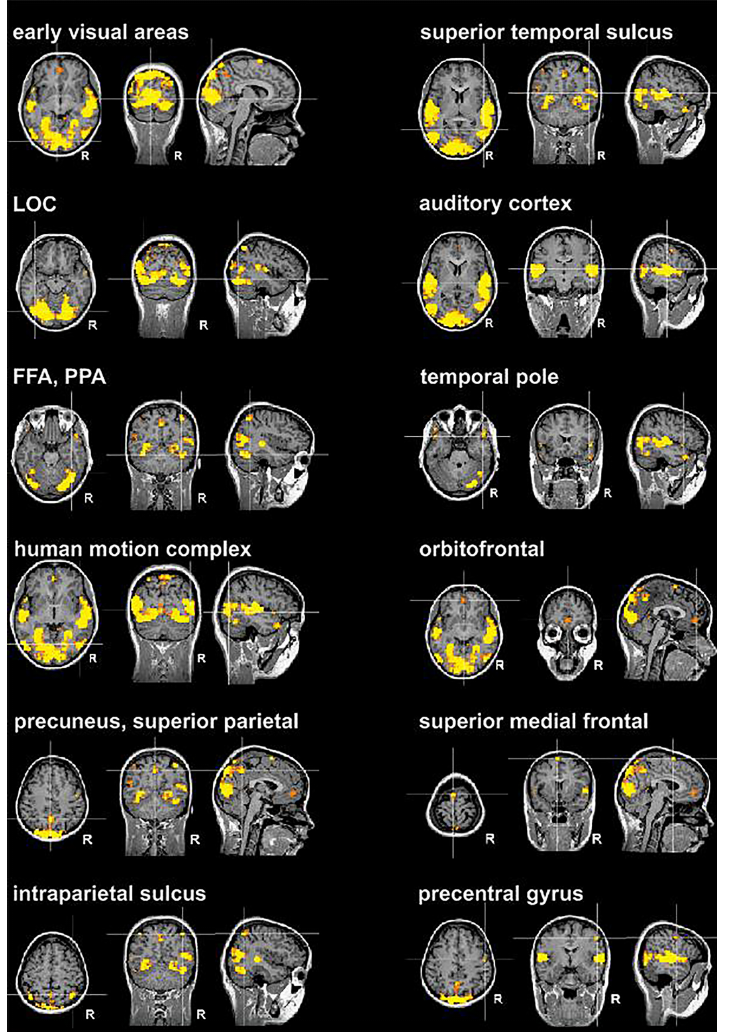
Figure 5 . Intersubject information map. In each panel, an axial, a coronal, and a saggital slice intersect in a different cortical region (panel label). In each slice, the positions of the other two slices of the panel are marked by white lines forming crosshairs. The intersubject information statistic is the fi rst canonical correlation between searchlights placed at corresponding locations in Talairach space. The searchlight-average activation has been subtracted out for each time point in each subject. The map is thresholded to control the false-discovery rate at